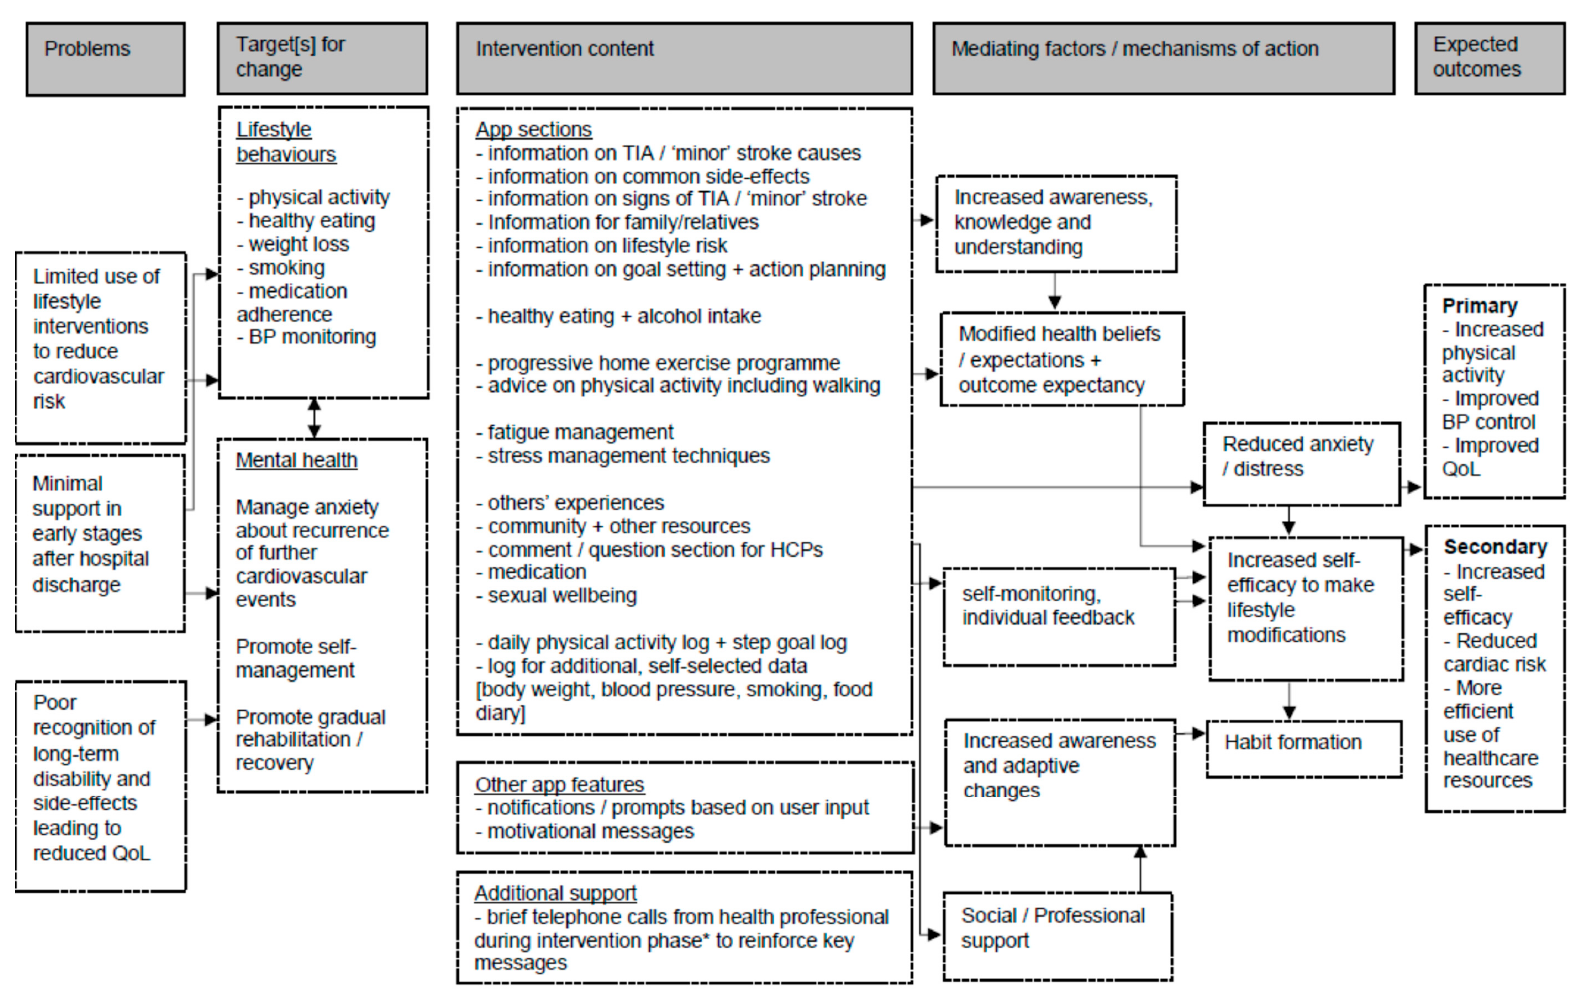
Figure 2. Logic model for mobile app to support patients after transient ischaemic attack or minor stroke (‘Brain-Fit’). QoL = quality of life; BP: blood pressure; HCP: Healthcare Proffessionals. * Included as part of intervention delivery during planned pilot